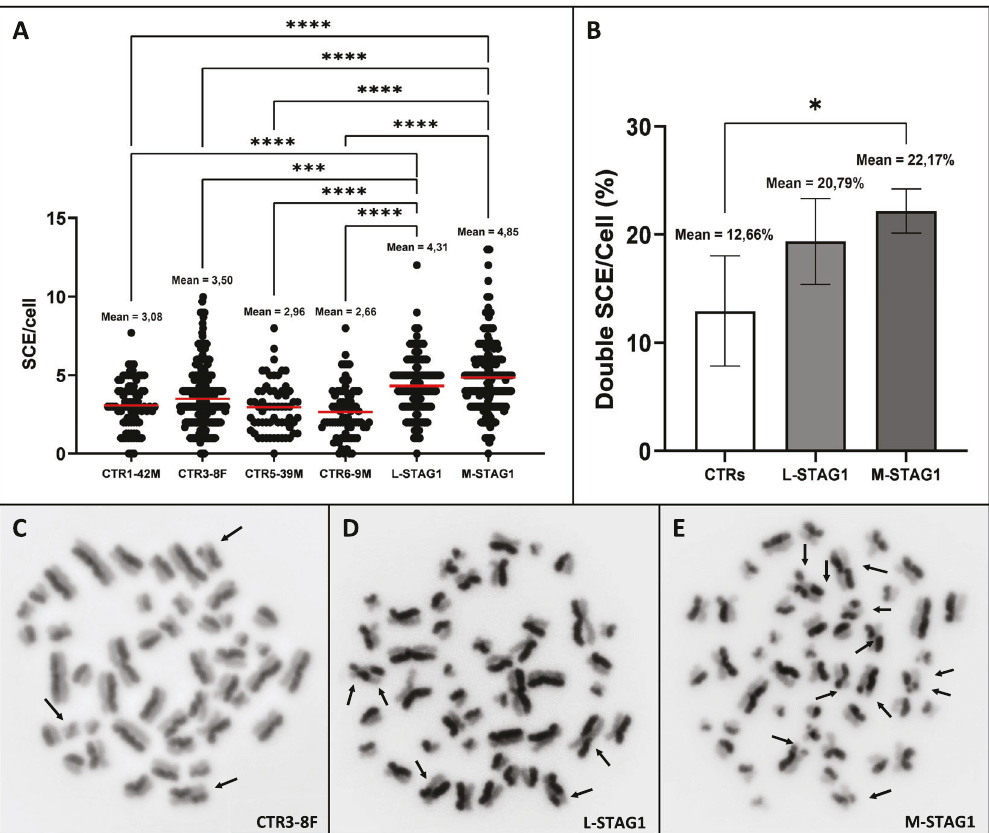
Fig. 1 Sister chromatids exchange (SCE) incidence in LCL cells. A shows the higher number of SCE in L-STAG1 and M-STAG1 compared to control LCLs. B indicates the percentage of cells with double exchanges, which is signi fi cantly higher in M-STAG1. C – E show representative metaphases with single/double abnormal chromatid exchanges observed at fl uorescence microscopy in CTR3-8F, L-STAG1, and M-STAG1, respectively. (Average of 88 metaphases for each line. Statistical analysis was performed by one-way ANOVA with Bonferroni ’ s multiple comparison correction. * <0.05; **<0.01 ***<0.001;